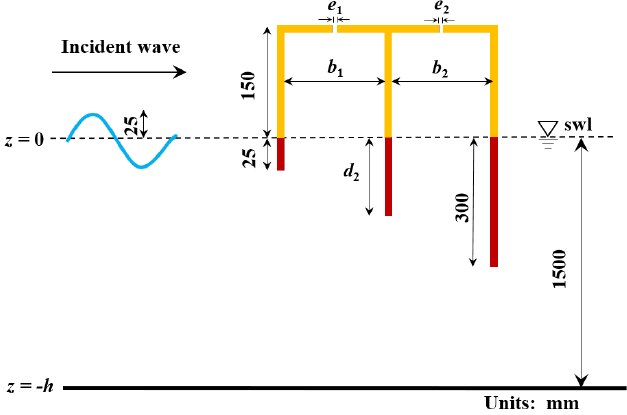
Figure 6. Schematic diagram of the dual-chamber device proposed by Elhanafi et al.